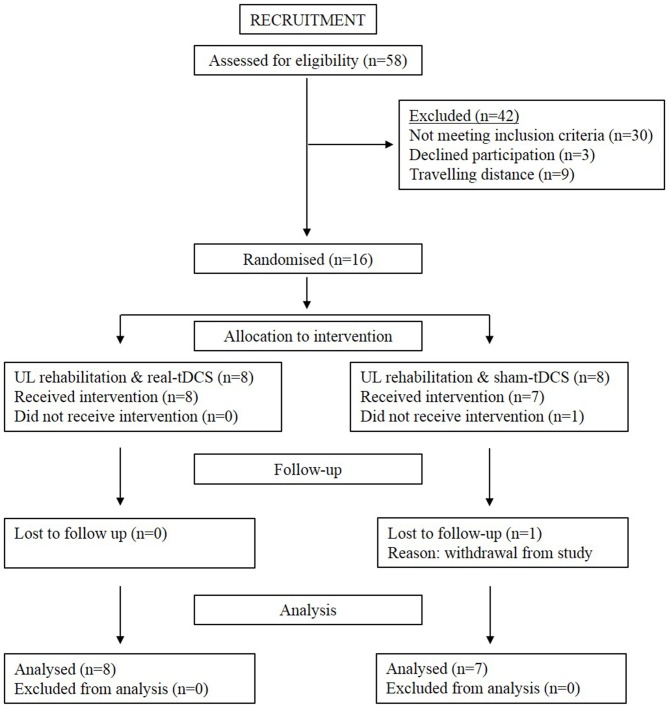
Consort diagram depicting flow through the study from recruitment to analysis.